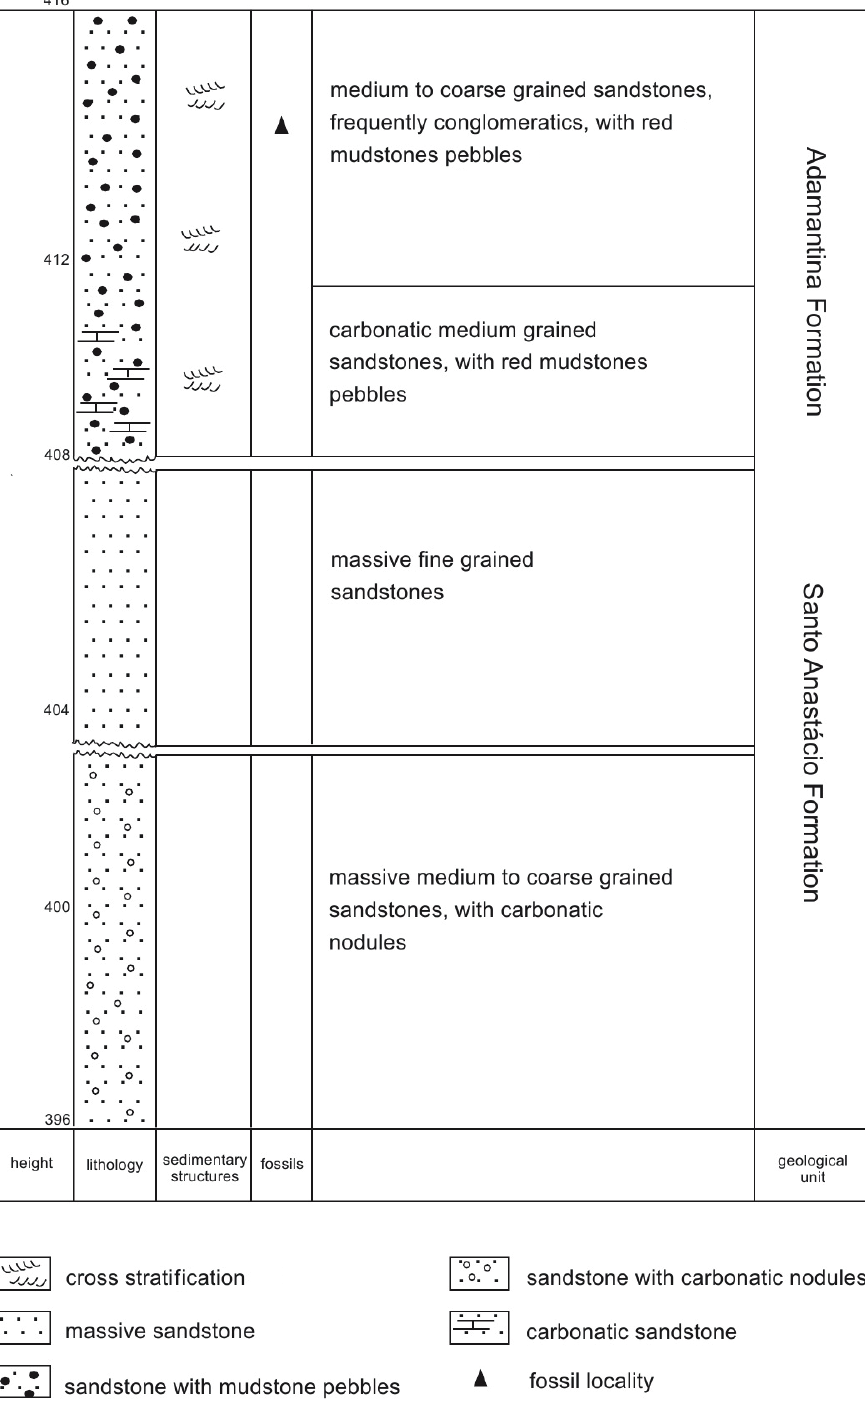
Figure 2 - Columnar section from the abandoned quarry on the outskirts of the Santo Anastácio Municipality, Southwestern São Paulo